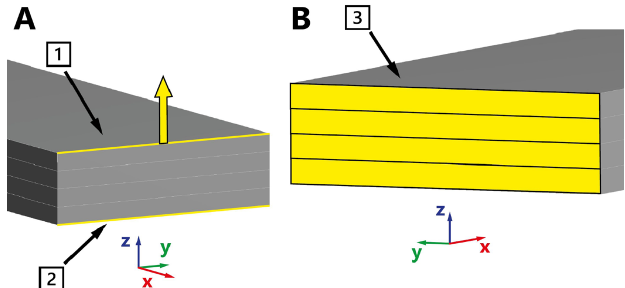
Figure 2. Boundary conditions applied to the finite element model. BC1 and BC2 (marked with corresponding numbers in squares) provide proper dilation of the composite layers. BC3 ensures that all of the nodes of the back area move